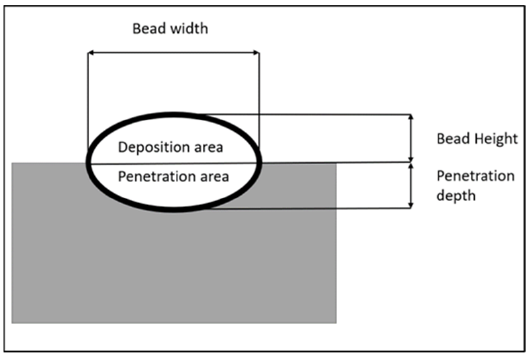
Figure 3. Diagram of sample cross section and associated dimensions.